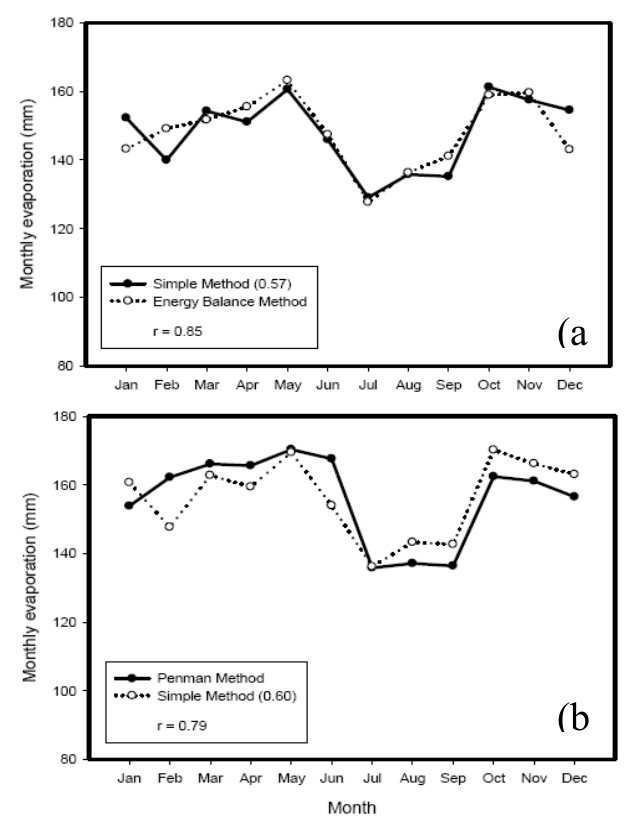
Figure 6. Comparison of models for estimates of Lake Ziway evaporation (a) Energy balance vs . Simple Method (b) Penman vs . Simple